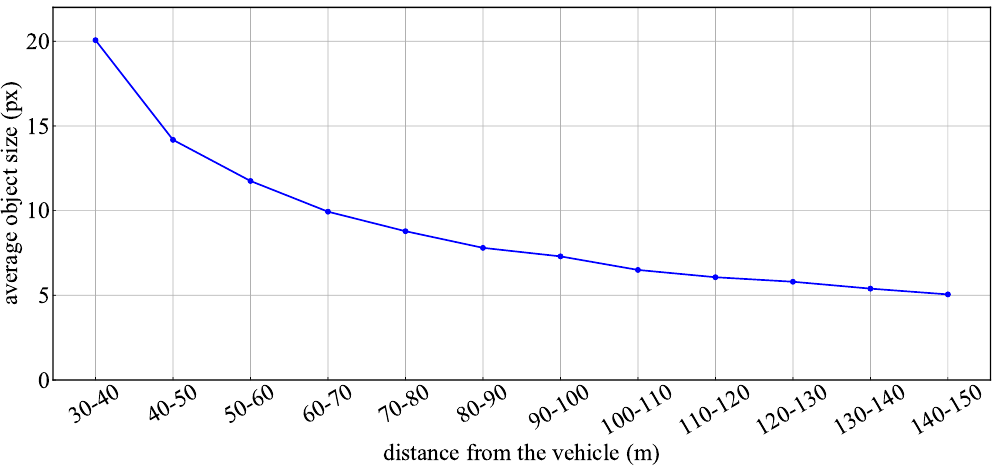
Figure 14. Average pixel size of the lighting area at different distances. Table 5. Experimental results of the proposed method in different distance